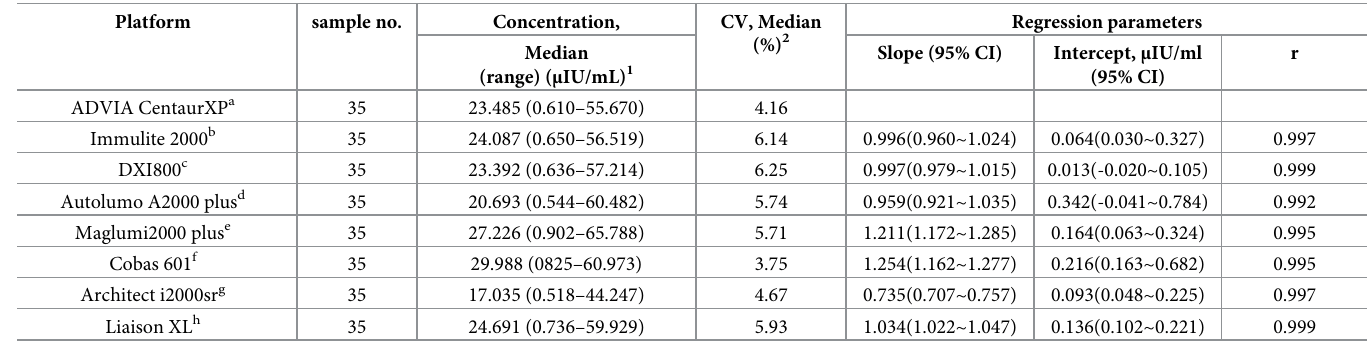
Table 2. Passing–Bablok regression analysis measured TSH values using NCCL EQA materials (2016~2019) after commutability-related biases were corrected. Platform sample